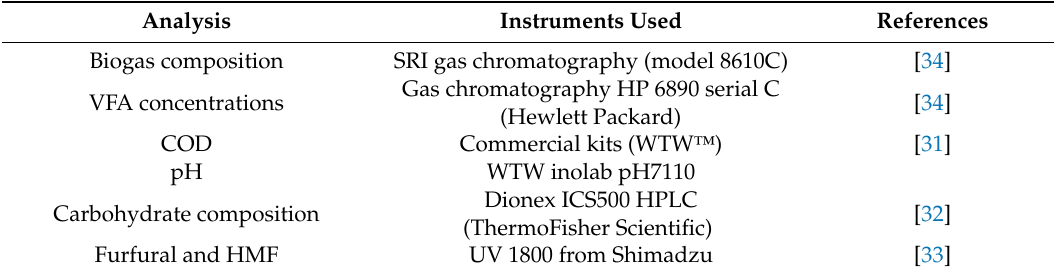
Table 5. Various analysis carried out during the experiment using di ff erent